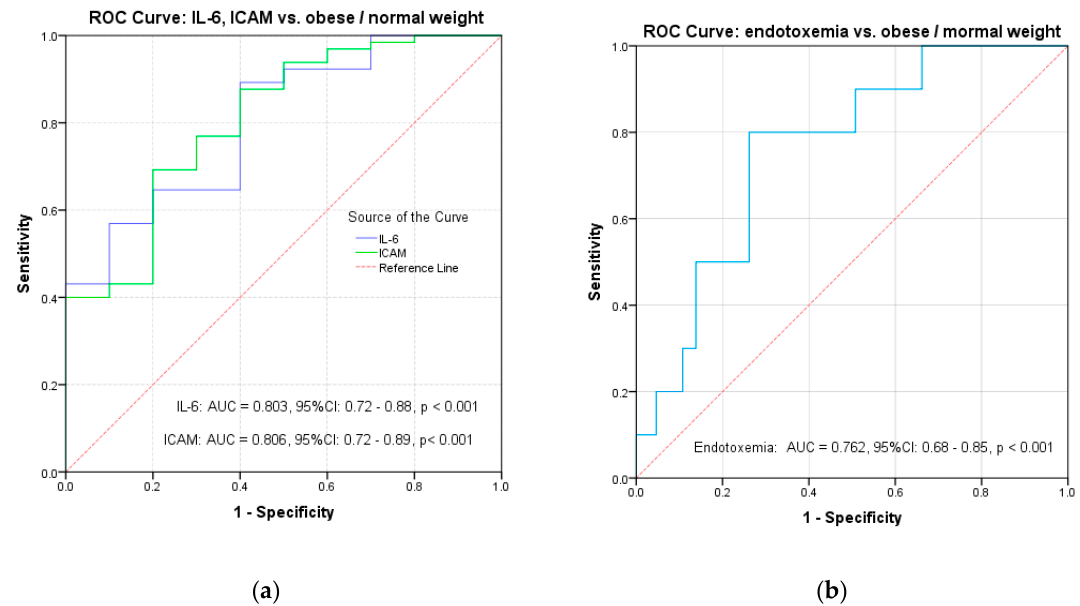
Figure 2. ROC curves for BMI vs. ( a ) IL-6 and ICAM and ( b ) endotoxemia.